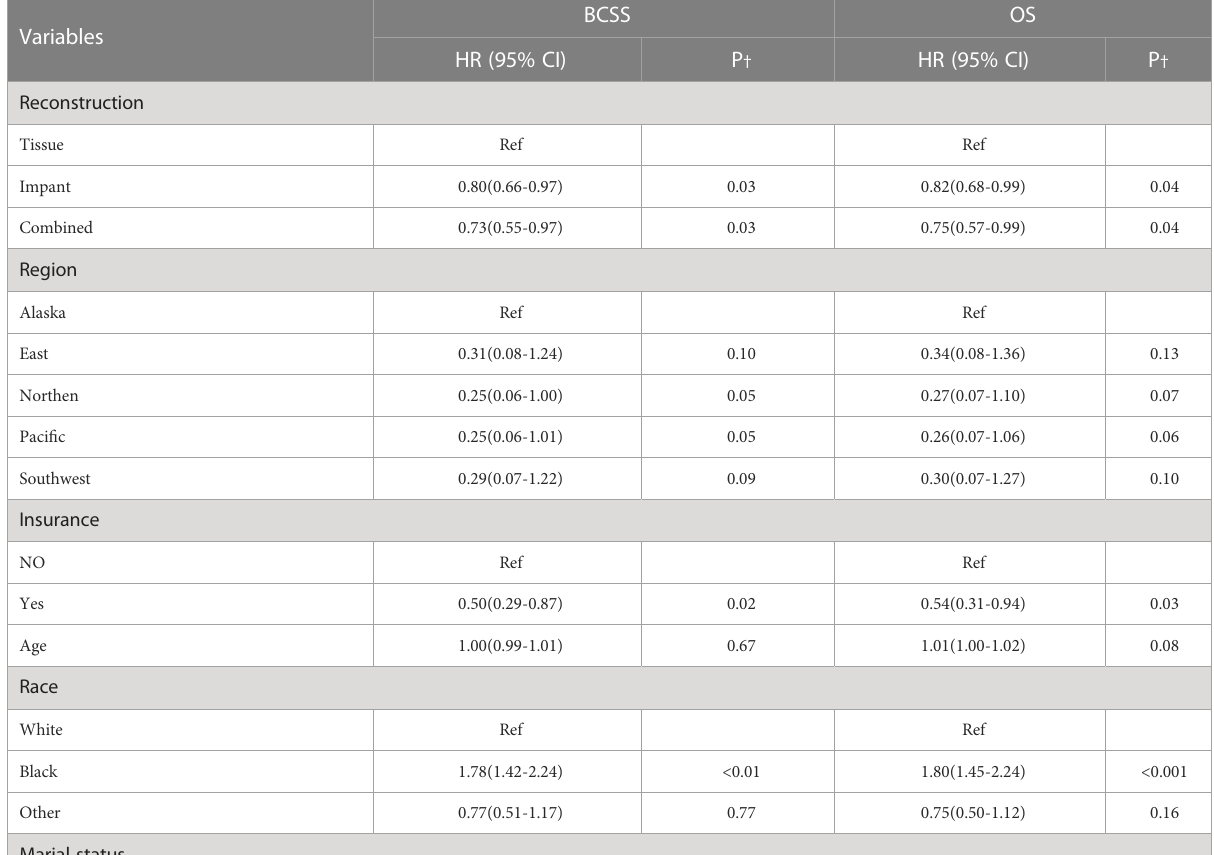
TABLE 2 Univariable Cox proportional hazard regression model of breast cancer-speci fi c survival (BCSS) and overall survival (OS).